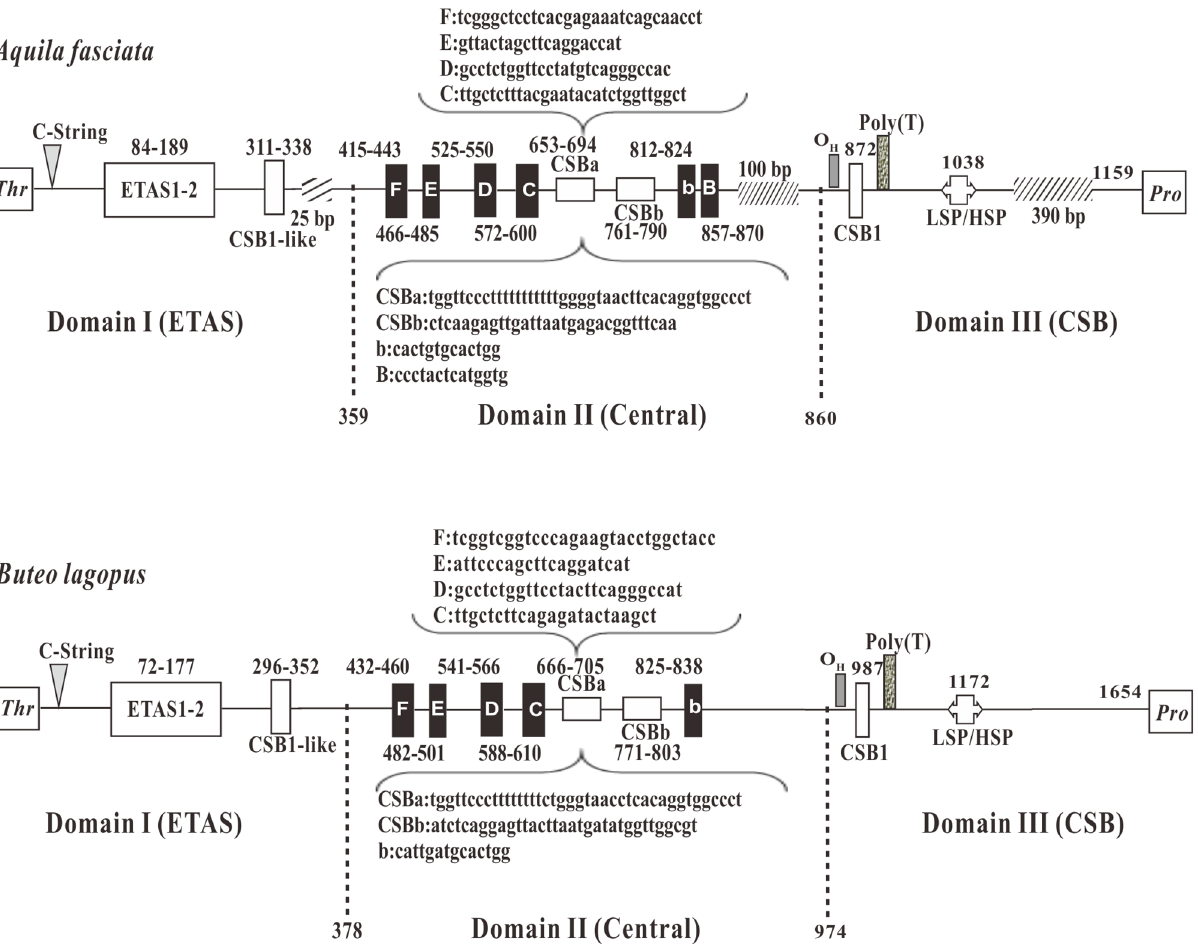
Fig 4. The structures of control region (CR) in mtDNA of A . fasciata and B . lagopus . Positions of the conserved boxes and the division into the three domains Domain I (ETAS), Domain II (Central), Domain III (CSB) are shown. ETAS = extended termination-associated sequences; F through B boxes = conserved sequence boxes in the central domain, CSBa is highly conserved stretches that vary in length, while CSBb is more variable; CSB = conserved sequence block; CSB-like = a sequence similar to the CSB; LSP = light-strand transcription promoter; HSP = heavy-strand transcription promoter; twill box means the comparison of two CRs, the lack of base